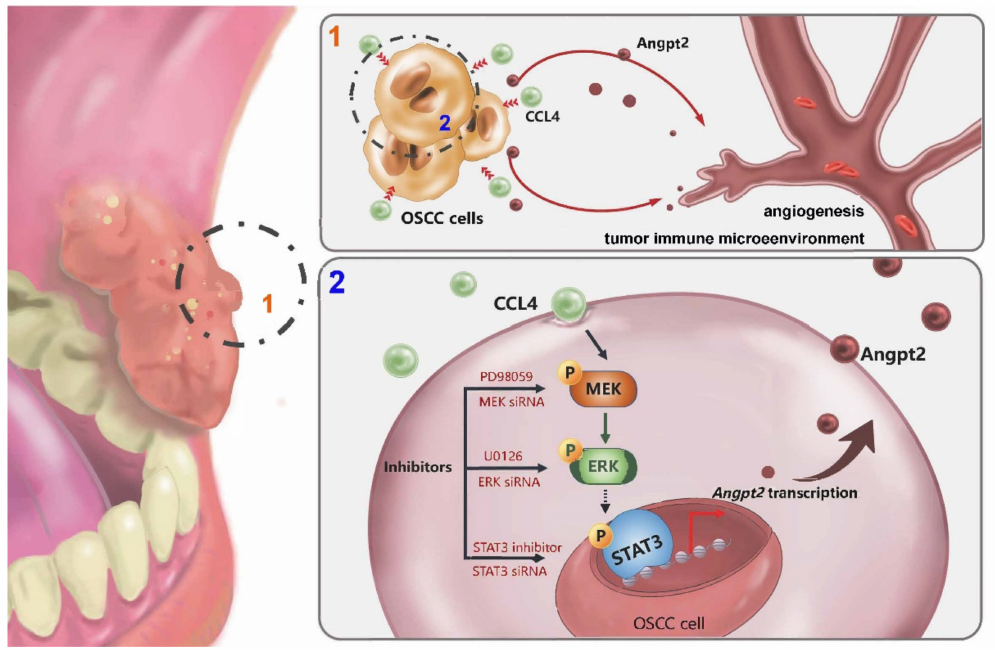
Figure 7. The schema depicts the involvement of signaling pathways in CCL4-induced stimulation of Angpt2 expression and the subsequent stimulation of OSCC